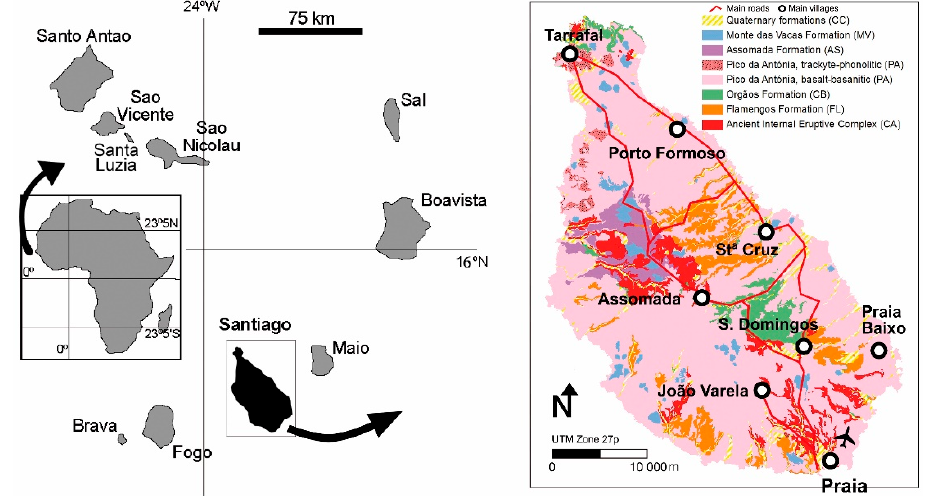
Figure 1. The Cape Verde Archipelago and its location on Senegal’s western coast, adapted from [7] and geological cartography of the island of Santiago, Cape Verde, adapted from [49].